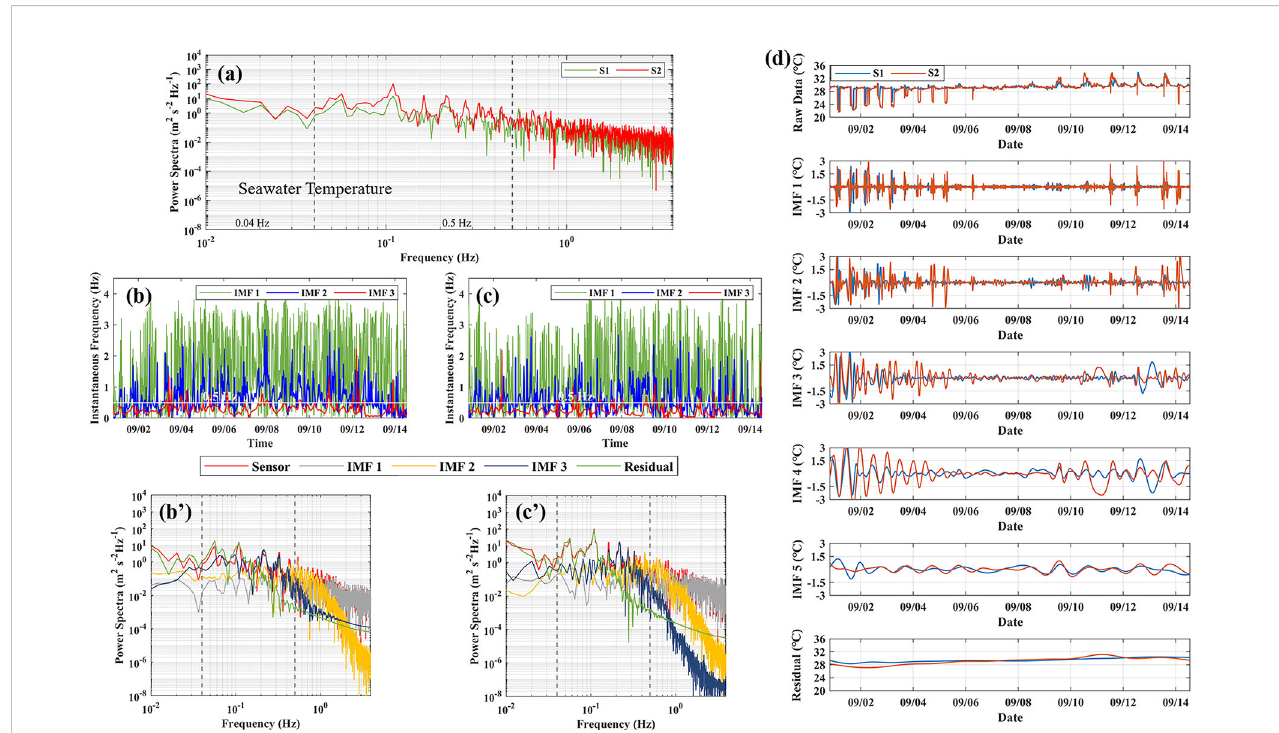
FIGURE 12 (A) The power spectra of the sea water temperature: S1 (green) and S2 (red). The gray dashed lines indicate the frequency of 0.04 Hz and 0.5 Hz, respectively. (B, C) Instantaneous frequency time series of IMF 1 – 3 of the sea water temperature: (B) S1 and (C) S2. (B ’ -C ’ ) The power spectra of the sea water temperature (red) and its decomposed IMFs and residual: (B ’ ) S1 and (C ’ ) S2. (D) Time series of EMD decomposition results of sea water temperature. From top to bottom: raw data, IMF 1-5, and residual (August 31 to September 15, 2019).